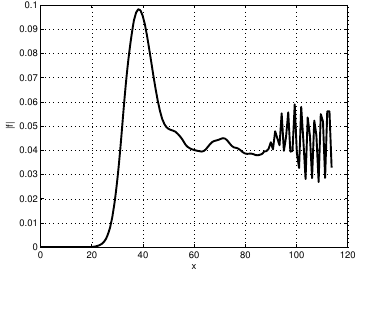
Figure 21. MATLAB solution for | f ( t f ,x ) | , Re( f ( t f ,x )), Im f ( t f ,x )), t f =